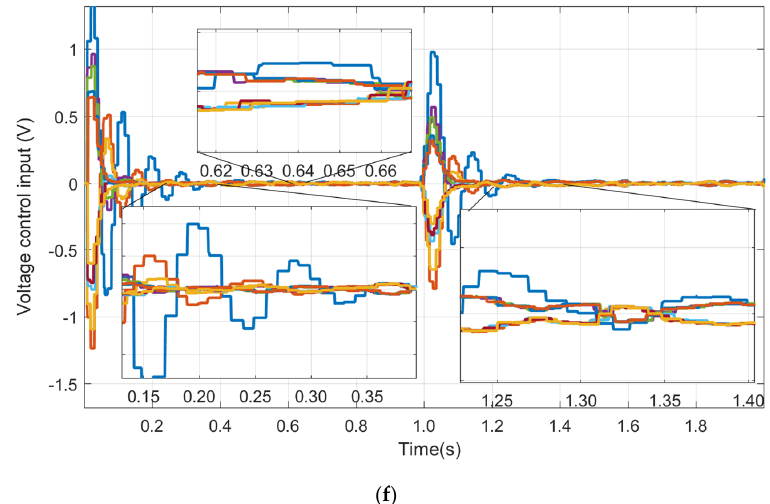
Figure 17. Simulation results for reactive power output with power generation fluctuation: ( a , b ) with periodic communication; ( c , d ) with ETCP; ( e ) control input of periodic communication; ( f ) control input of ETCP. Energies 2020 , 13 , x FOR PEER REVIEW